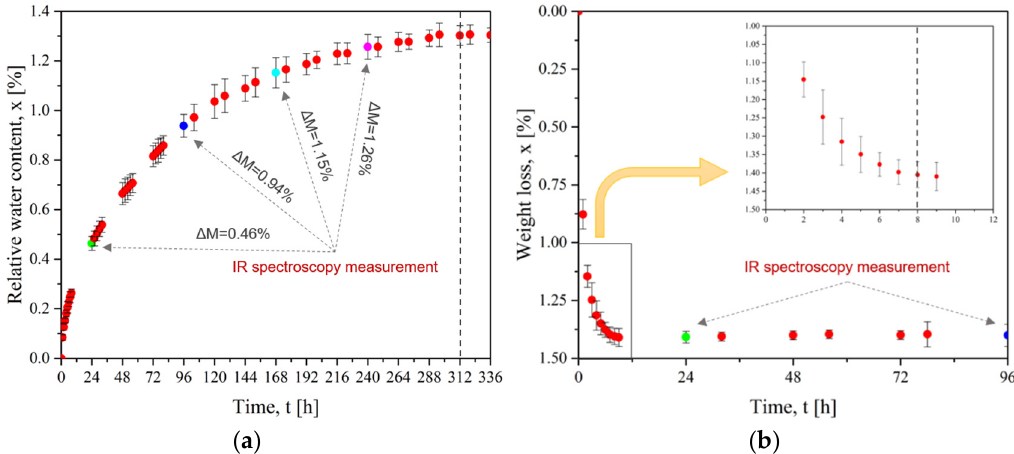
Figure 5. For PEI ( a ) Evolution of water diffusion at 25 °C and ( b ) Evolution of mass loss with drying time at 150 °C (dots of different colors represent measurement by FTIR spectroscopy).